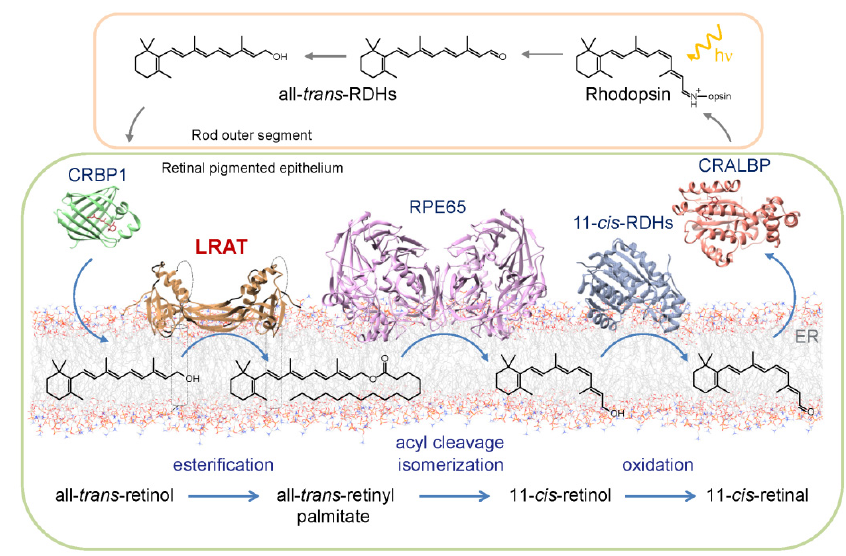
Figure 3. The enzymatic production of the visual chromophore via canonical retinoid (visual) cycle. 11 ‐ cis ‐ Retinal regeneration is initiated in the photoreceptor by photoisomerization of the chromophore bound to rhodopsin, its subsequent liberation and reduction to all ‐ trans ‐ retinol. In RPE cells, all ‐ trans ‐ retinol is esterified by LRAT prior to isomerization that is accompanied the acyl cleavage of the ester bond. Resulting 11 ‐ cis ‐ retinol is then oxidized to the corresponding aldehyde. These metabolic transformations occur in the smooth ER, where key enzymes of the visual cycle are located. The retinoid cycle is completed by transport of 11 ‐ cis ‐ retinal back to the photoreceptors, where it conjugates with opsin and thus regenerates visual pigment. Structures of cellular retinol ‐ binding protein 1 (CRBP1), retinoid isomerase (RPE65) and cellular retinaldehyde ‐ binding protein (CRALBP) correspond to PDB accession numbers 5H8T [79], 3KVC [96], and 4CIZ [97], respectively. Generic model of 11 ‐ cis ‐ retinol dehydrogenases (11 ‐ cis ‐ RDHs) was built based on the structure of dehydrogenase from Drosophila melanogaster PDB accession number 5ILG.